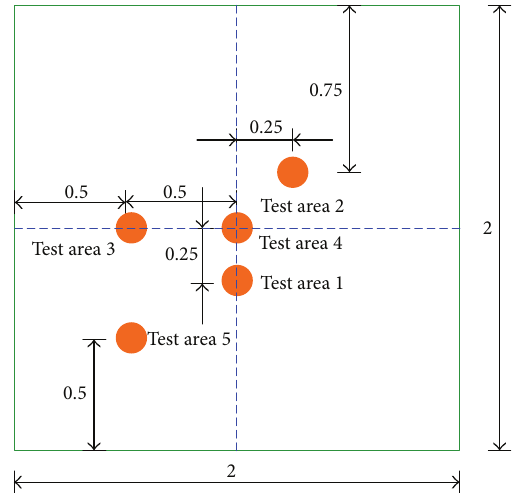
Figure 15: Diagram of CFG pile model test area (unit: